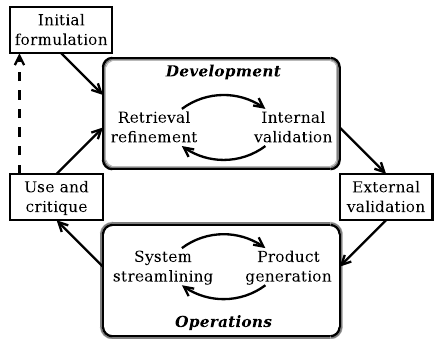
Figure 4. One-dimensional representation of a retrieval considering multiple systems (realisations of the forward model that do not nec- essarily retrieve the same variable). For a system, the retrieved state is the minimum of its cost function (indicated by a circle). The state with globally minimal cost (across all systems) is a posteriori taken as the best representation of the observed environment.